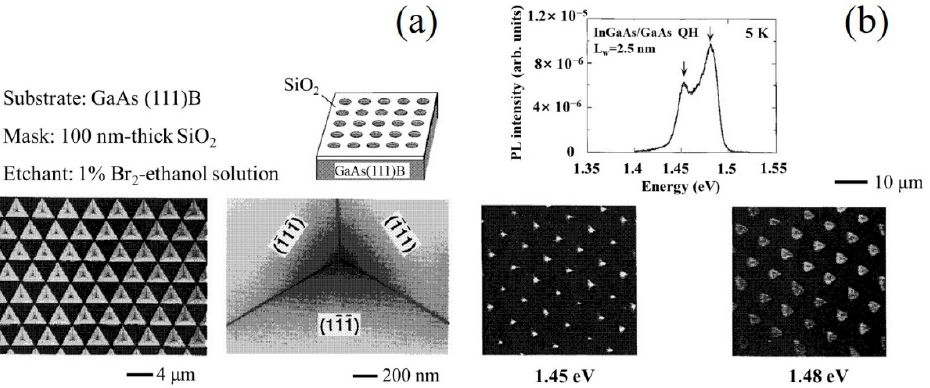
Figure 3. ( a ) SEM images of the patterned substrate and ( b ) PL and CL spectra of QD structures